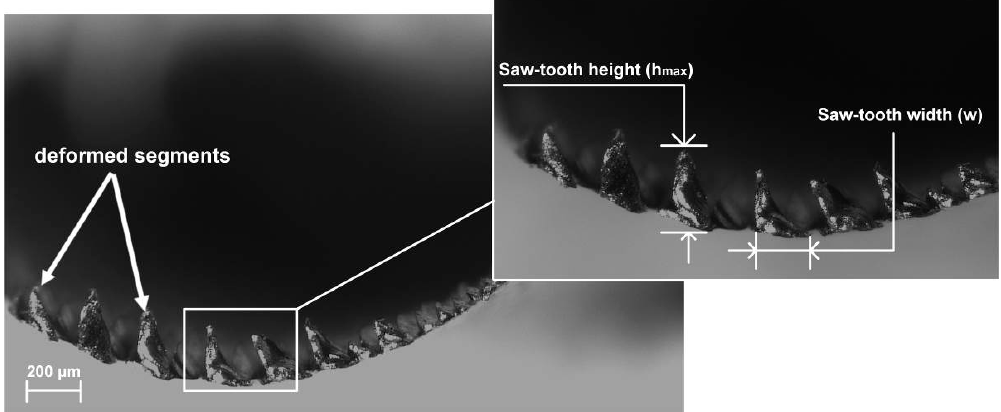
Figure 18. Side view of a deformed chip showing the serration of chips produced using Cut-list at 200 m/min and 0.1 mm/rev.